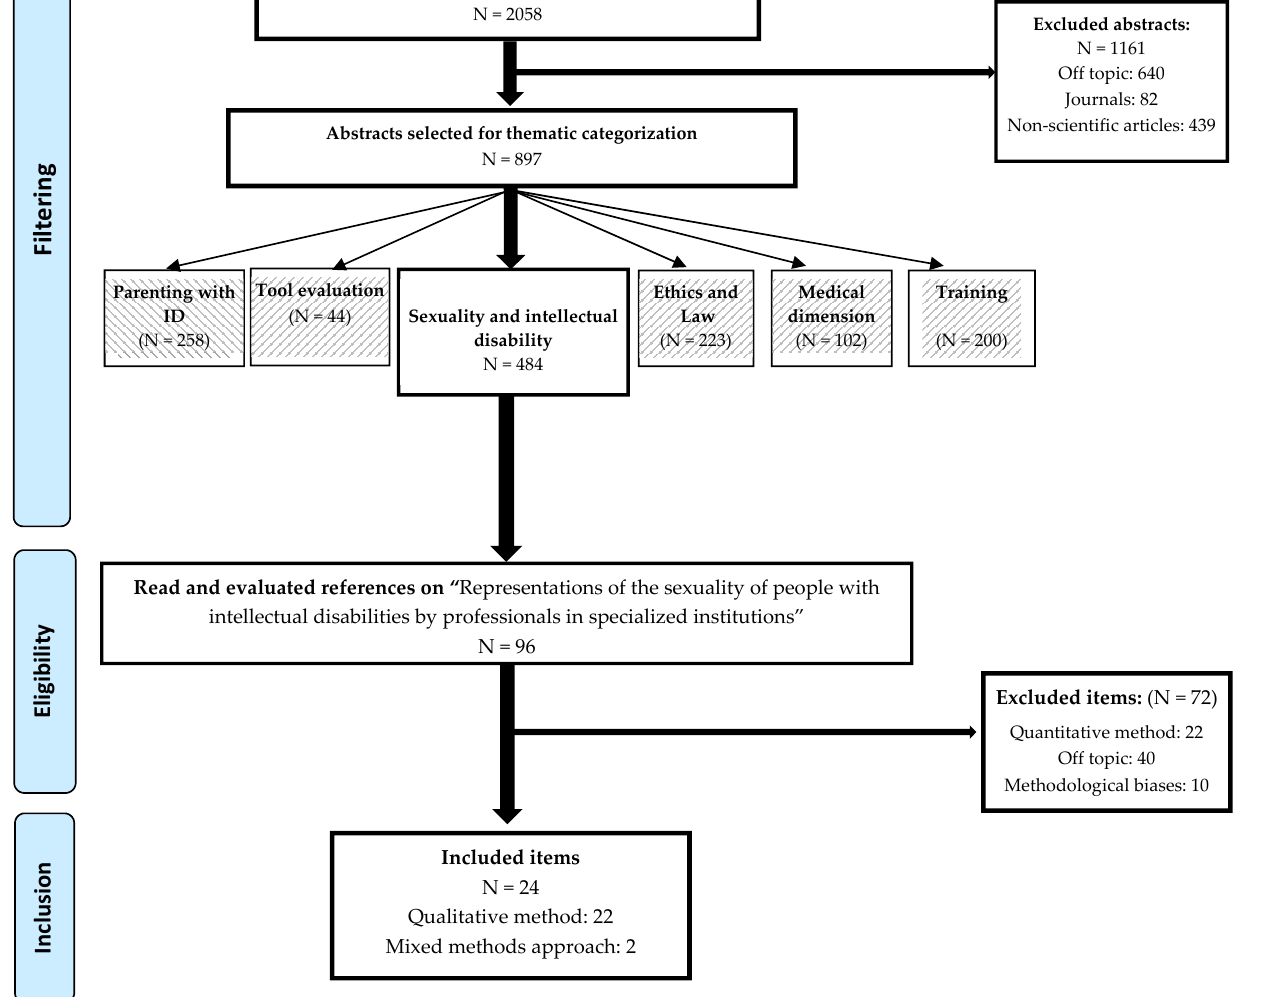
Figure 1. Flow diagram of the selection process relating to representations of the sexuality of people with intellectual disabilities by professionals in specialized